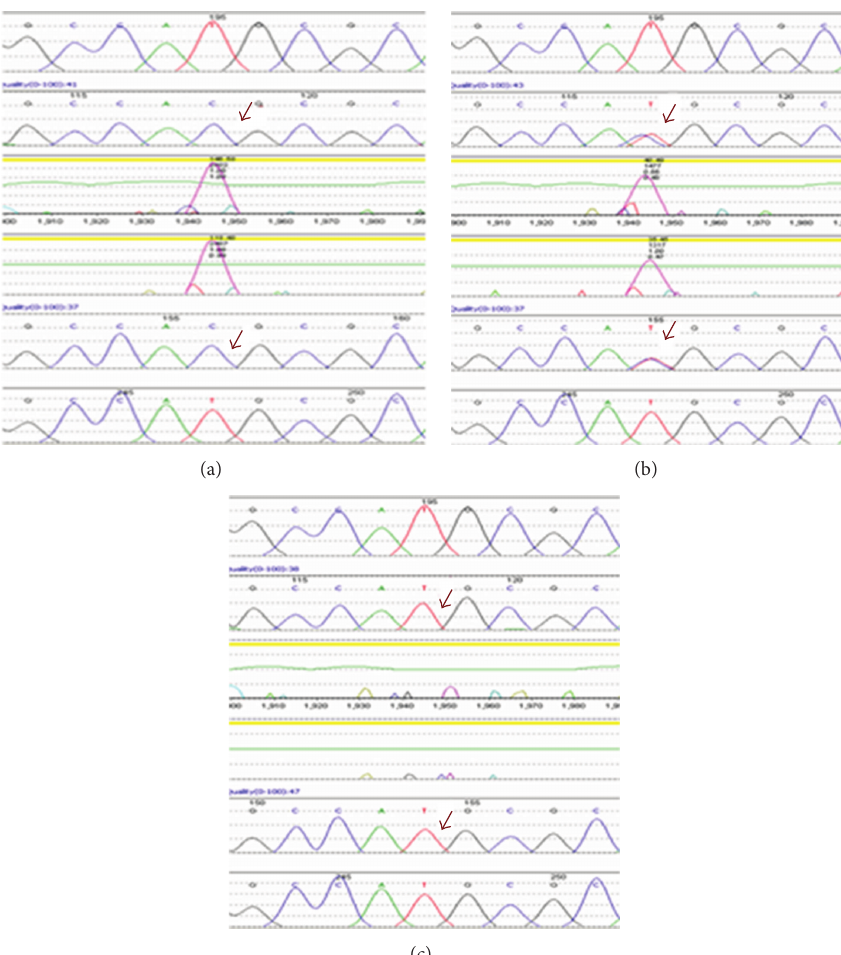
Figure 2: DNA sequencing results. (a) DNA sequencing revealed a homozygous mutation of c.1619T > C, p.M540T in the patient. (b) Mother is a carrier. (c) Father is not a carrier. The c.1619 nucleotide residue is depicted by an arrow in forward and reverse sequence traces for the patient and both parents. The sequence of a normal control sample is shown for each case for